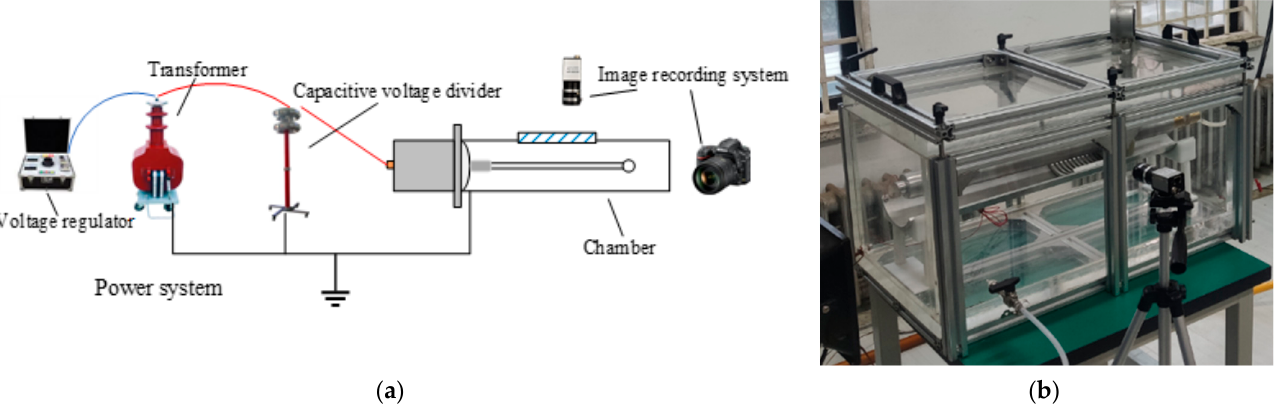
Figure 9. Test platform: ( a ) schematic diagram and ( b ) test chamber.